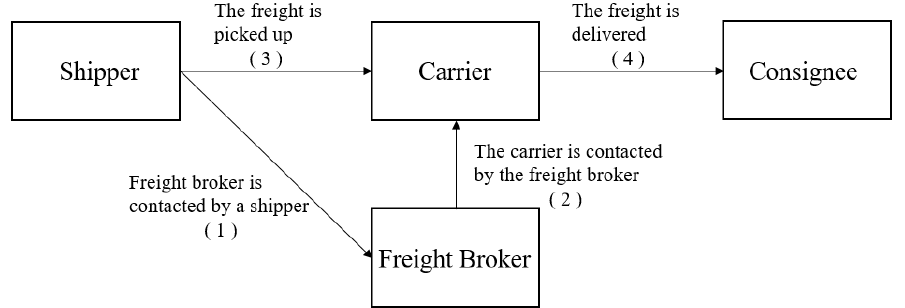
Figure 2. Life of a brokered freight load.